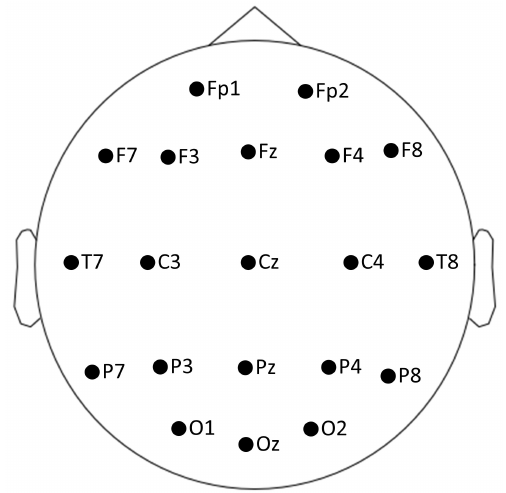
Figure 1. Scalp positioning of the 20 common EEG channels used in our data